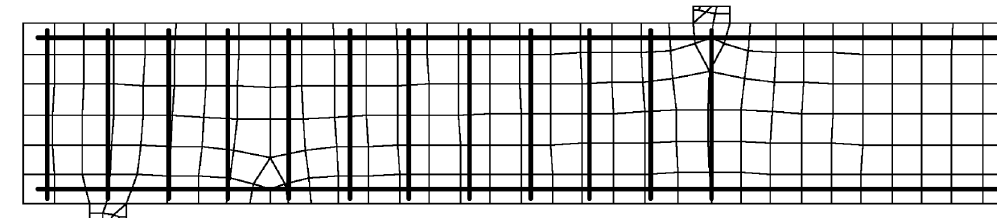
Fig. 11. Finite element meshing of a